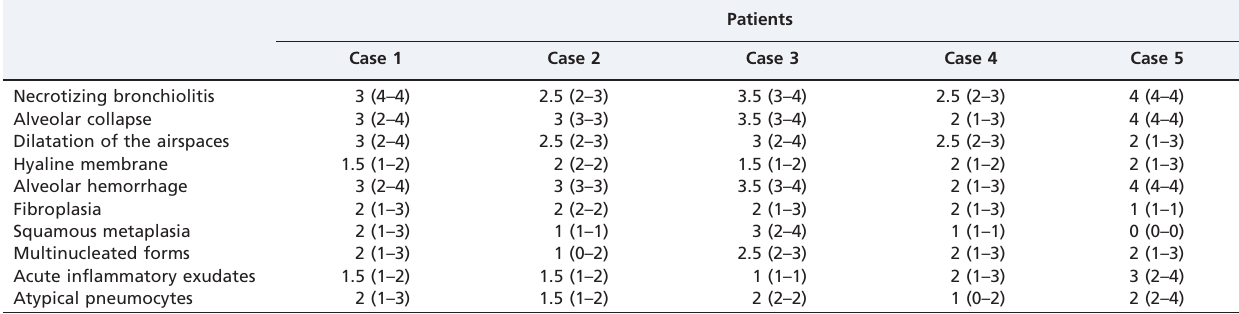
Table 2 - Semiquantitative analysis of pulmonary pathological features of patients with severe acute lung injury.